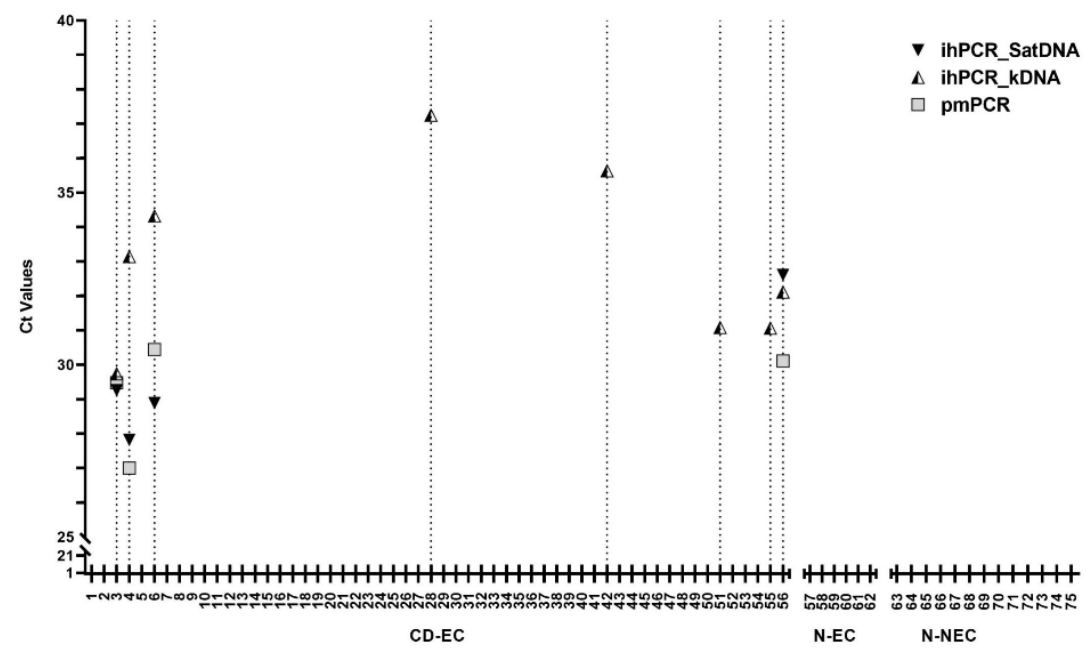
Figure 2. Ct values obtained with in-house real-time PCR (ihPCR) (satellite DNA (SatDNA) and kinetoplast DNA (kDNA)) and pmPCR. CD-EC = blood samples from patients with Chagas disease from endemic country; N-EC = blood samples from patients negative for Chagas disease from endemic country; N-NEC = blood samples from patients negative for Chagas disease from nonendemic country.